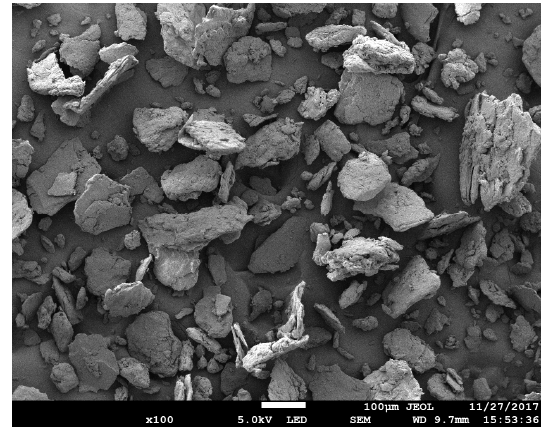
Table 1. Dimensions of CNC.